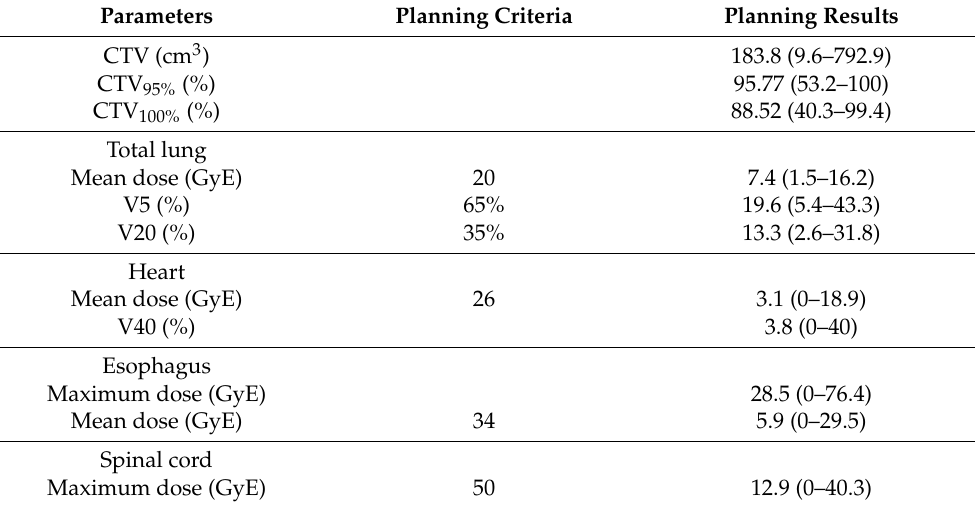
Table 2. Dose-volume parameters.